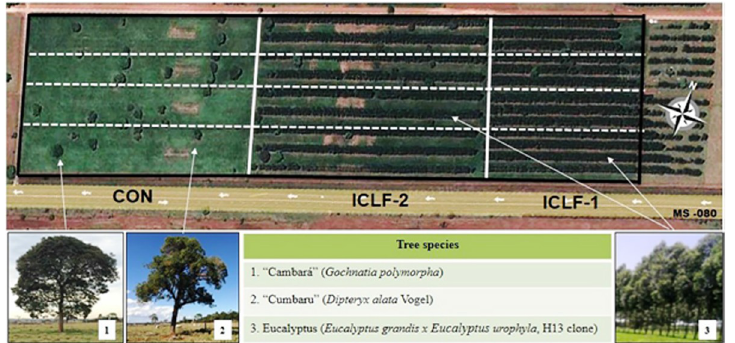
Fig 2. Experimental site and the representation of the tree species present in the integrated crop-livestock-forest (ICLF) systems (ICLF-1 and ICLF-2) and the control (CON) system.